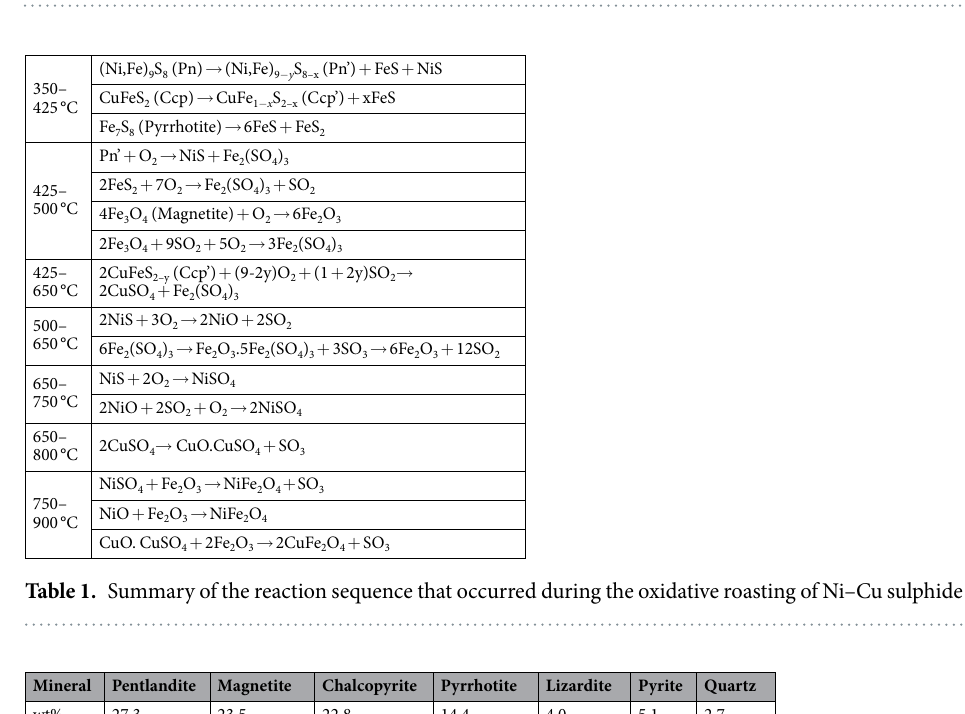
Figure 7. Schematic of the oxidative–roasting mechanisms of Pn ( a ) and Ccp ( b ) in the Ni–Cu sulphide ore. Four temperature ranges were defined, and a four–stage reaction sequence occurred.